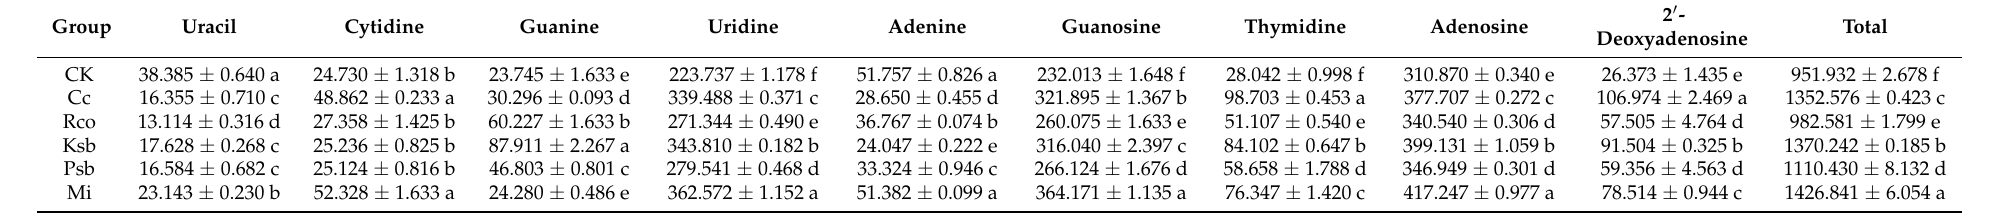
Table 4. The nucleoside content of F. taipaiensis bulbs treated by different microbial inocula ( µ g · g − 1 , fresh